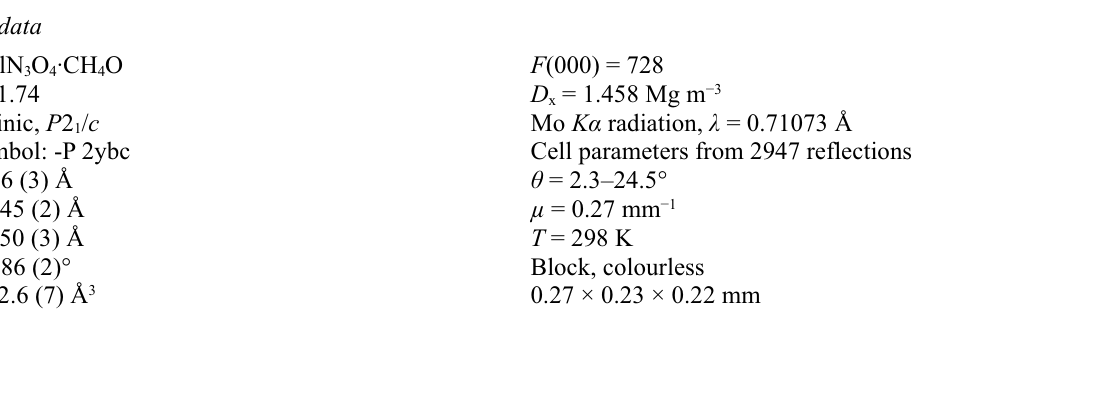
The crystal packing of the title copound, viewed along the a axis. Hydrogen bonds are shown as dashed lines. N ′ -(2-Chloro-5-nitrobenzylidene)-3-hydroxybenzohydrazide methanol